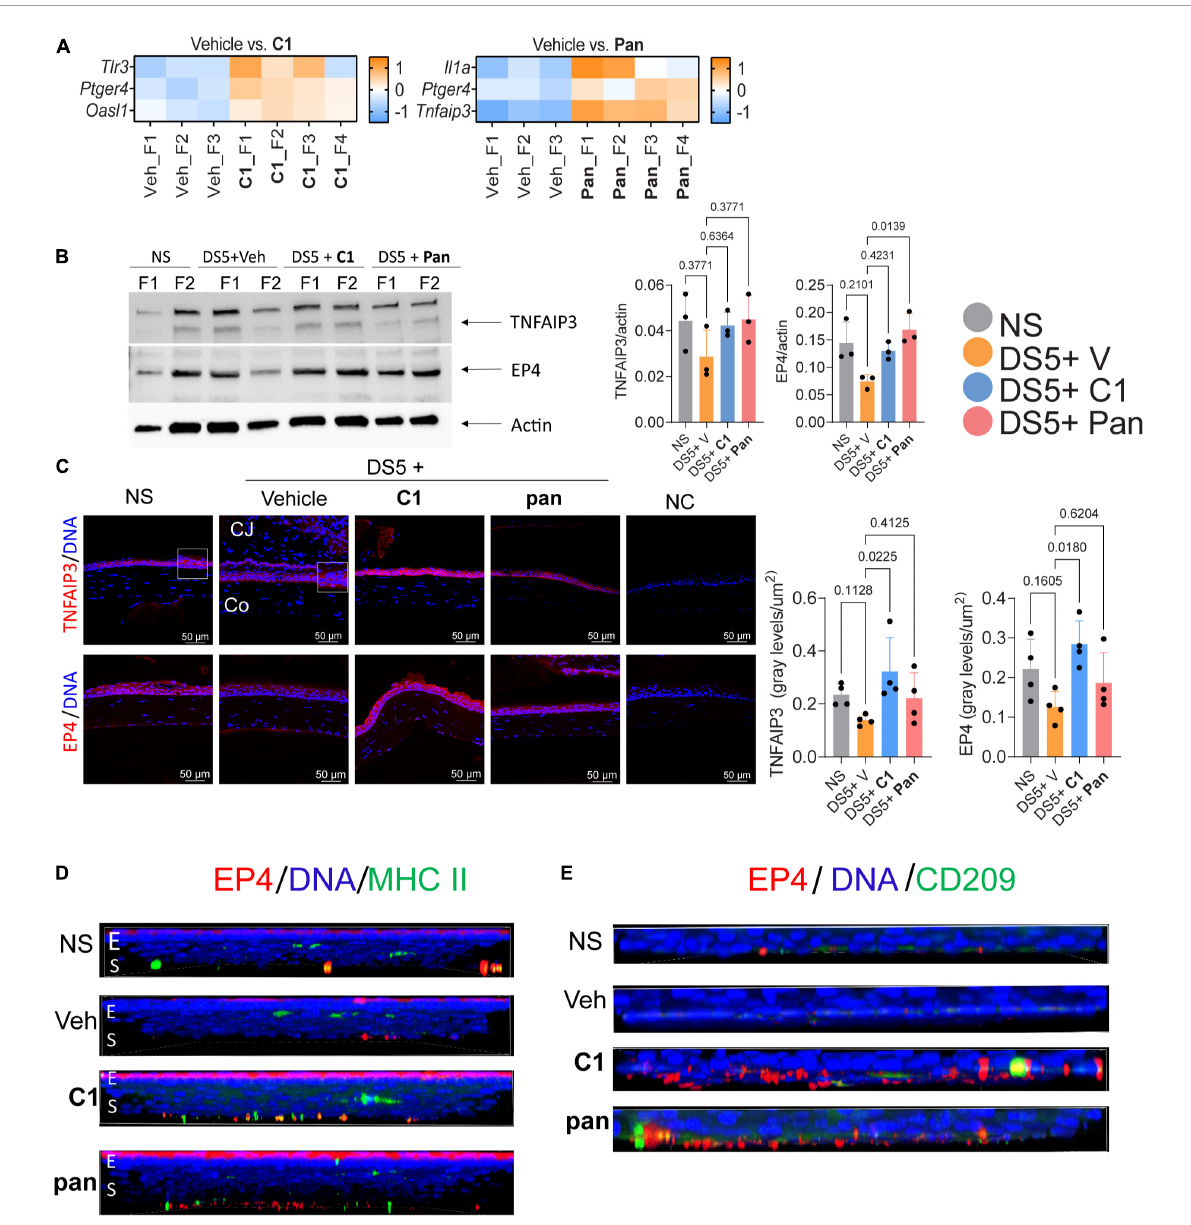
FIGURE3 Topical Treatment With C1 and pan Eye Drops Increase the expression of TNFAIP3 and EP4. (A) Heatmaps showing differentially expressed genes between the vehicle (Veh) and Pan or C1 corneas. Gene analysis using the NanoString Mouse Inflammation panel v2 was performed on the cornea of mice subjected to desiccating stress for 5 days ( n = 3–4/group). For all genes identified as significantly changed, log2 > 1.2 and p adj. < 0.05. (B) Representative western blot in corneal epithelium lysates that were blotted with anti-TNFAIP3 or EP4 antibodies. Beta-actin was used for loading control. Densitometry of the three samples per group is shown in the bar graphs. Non-parametric Kruskal–Wallis followed by Dunn’s multiple comparison test. Each dot represents one biological sample containing cells pooled from four animals. P-value as shown. (C) Merged images of laser confocal microscopy of cornea cryosections stained with TNFAIP3 or EP4 antibodies (red) with DAPI nuclear staining (blue). Insets are high magnification to the adjacent area. Bar graphs on the right indicate fluorescence intensity normalized by the area of corneal epithelium. Non-parametric Kruskal–Wallis followed by Dunn’s multiple comparison test. Each dot represents one biological sample. P-value as shown. CJ, conjunctiva; Co, cornea; NC, negative control. (D) Merged images of laser confocal microscopy of whole-mount corneas stained with EP4 (red) and MHC II (green) antibodies with DAPI nuclear staining (blue). Z stacks were collected for the EP4 images and rotated 90 degrees to show spatial distribution. E, epithelium; S, stroma. (E) Merged images of laser confocal microscopy of the stroma of whole-mount corneas stained with EP4 (red) and CD209 (green) antibodies with DAPI nuclear staining (blue). For EP4 images, Z stacks were collected and images were rotated 90 degrees to show spatial distribution. E, epithelium; S,